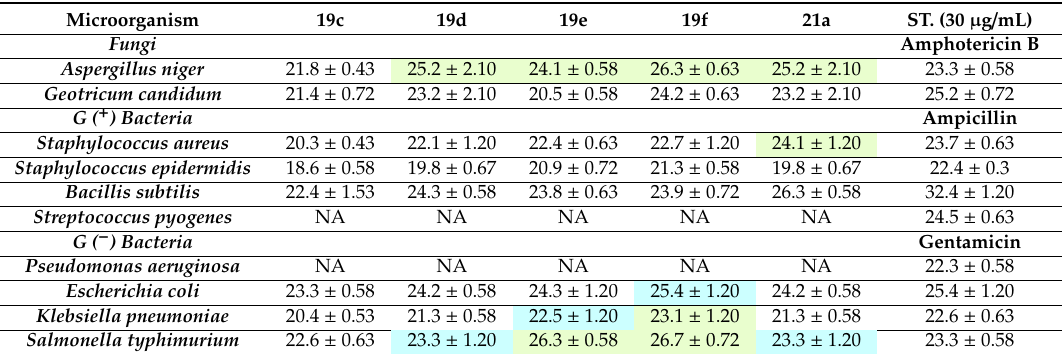
Table 4. Preliminary anti-microbial activity for compounds 13 , 14 , 17a , b and 19a Table 5. Preliminary anti-microbial activity for compounds 19c – f and 21a .